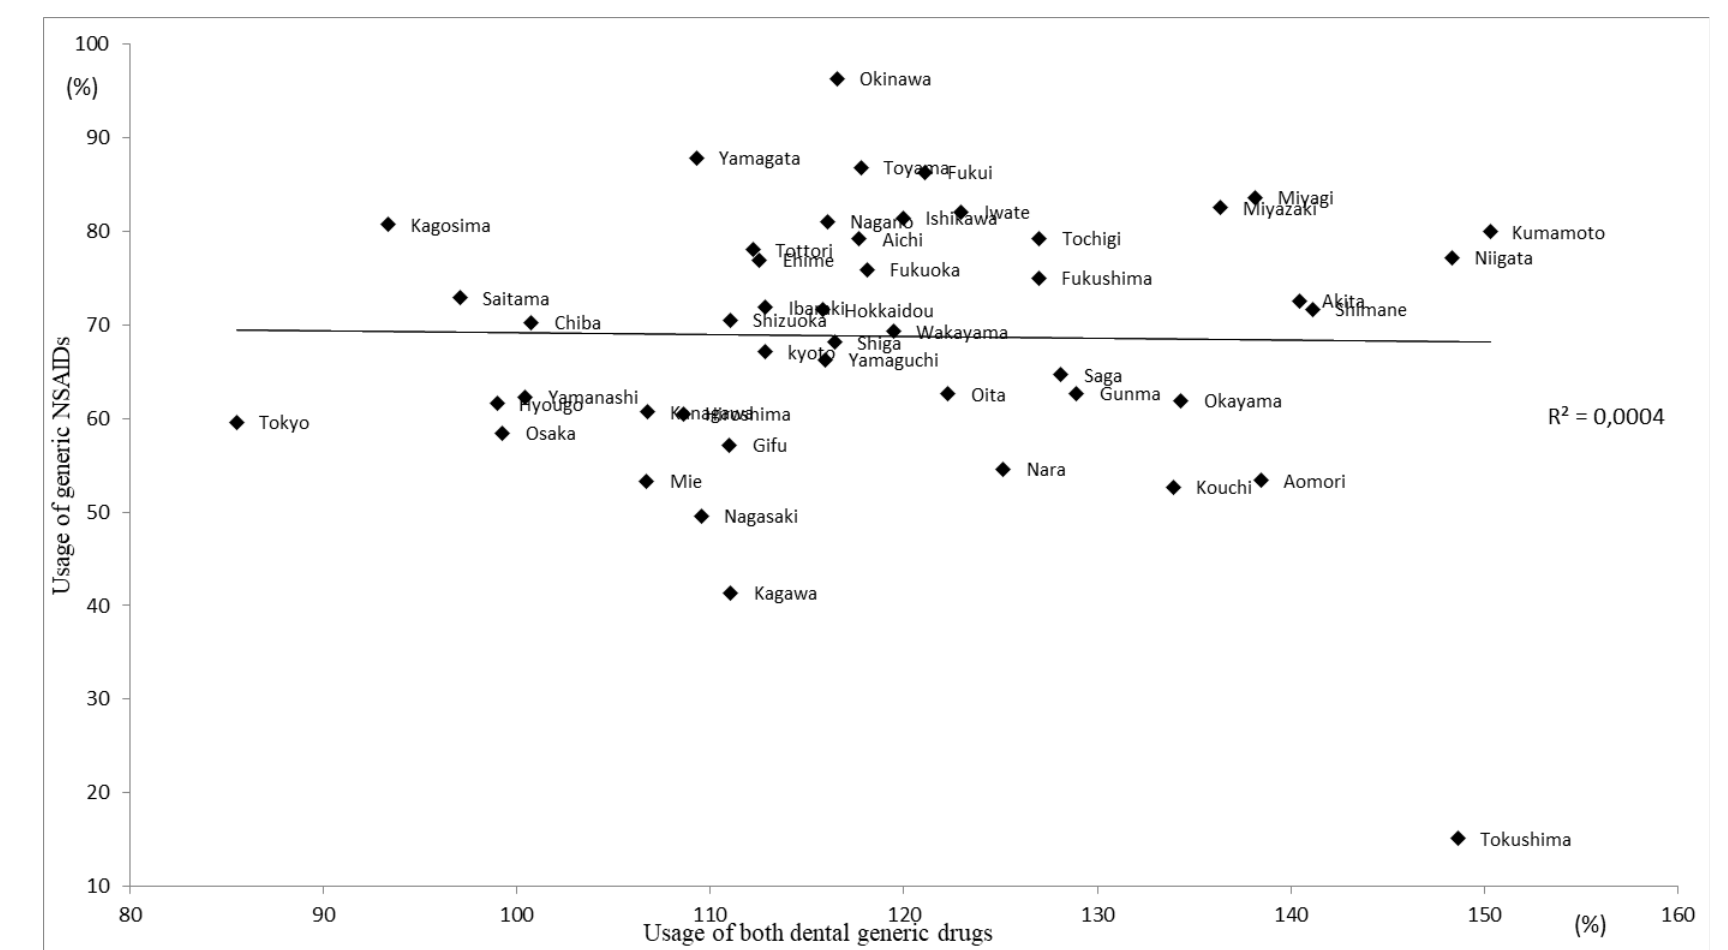
Figure 3. Comparison of usage of NSAIDs and both in-hospital generic drugs.